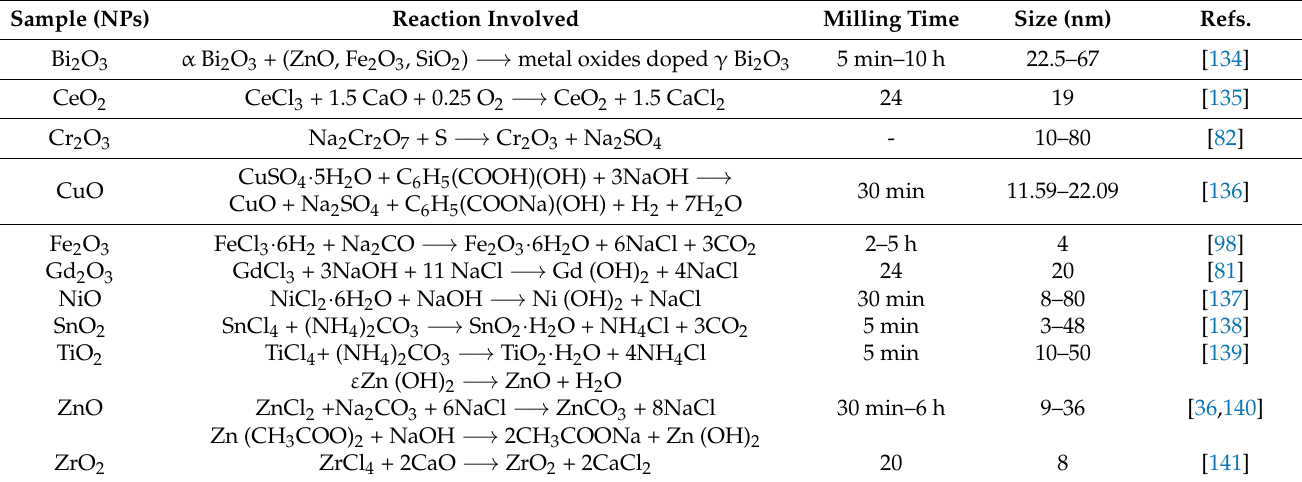
Table 3. Mechanochemical synthesis of various metal oxide nanoparticles. Sample (NPs) Reaction Involved Milling Time Size (nm)